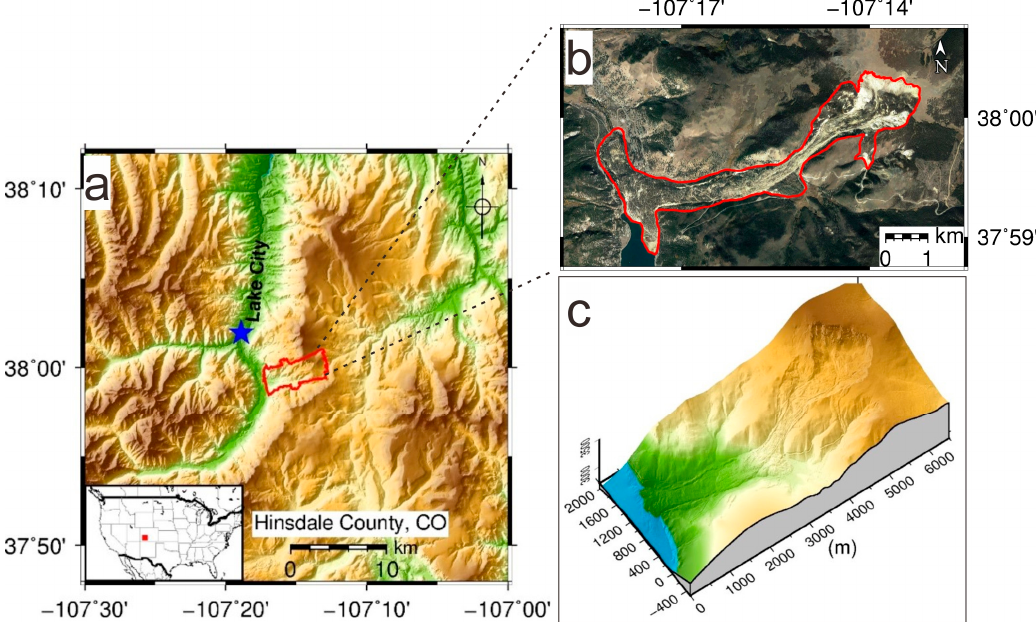
Figure 1. ( a ) A topographic map showing the location of the Slumgullion landslide located in the San Juan Mountains within Hinsdale County, Southwestern Colorado. The red box indicates the area covered by three ALS scans on 3, 7, and 10 July 2015. The elevation data (1/3 arc-second digital elevation model (DEM)) is from U.S. Geological Survey (https://viewer.nationalmap.gov). ( b ) A Google Earth image showing the vegetation coverage in the landslide area. ( c ) A 3D digital elevation model (DEM) showing the extension of the Slumgullion landslide in space. The DEM is derived from the bare-earth ALS data collected on 7 July 2015. The unit of the three axes is in meters.